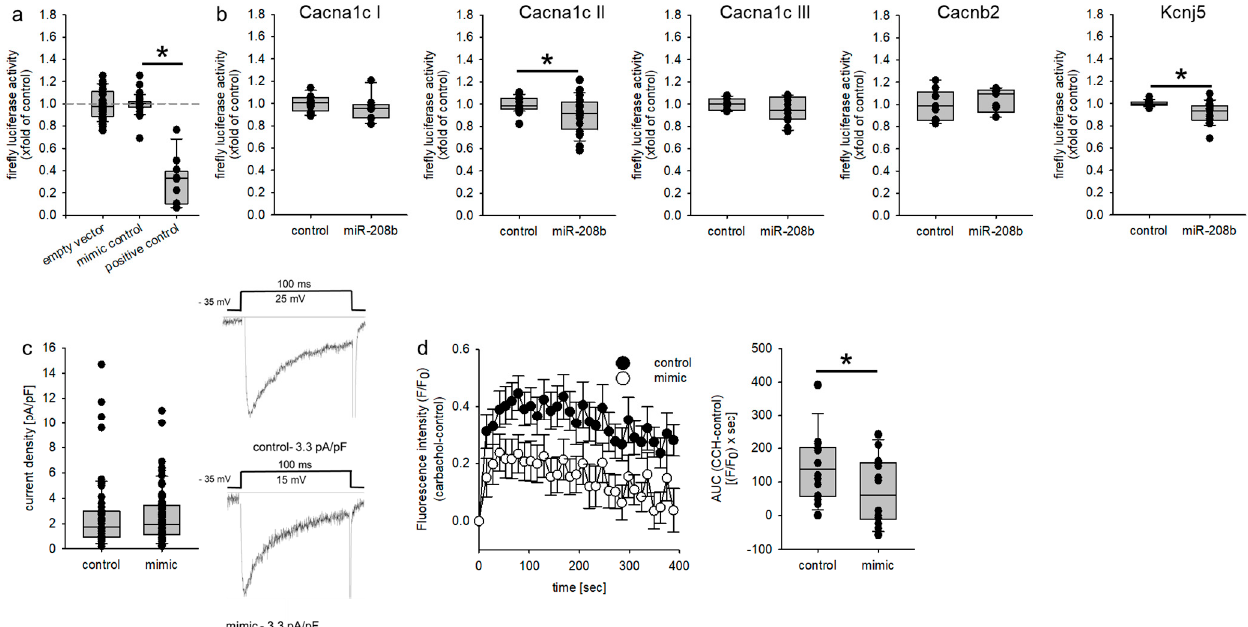
Figure 3. ( a ) HEK293 cells were transfected with either an empty vector or a luciferase vector containing a miR-208b-binding site. Co-transfection with mimic control had no significant effect on firefly luciferase activity, while co-transfection with